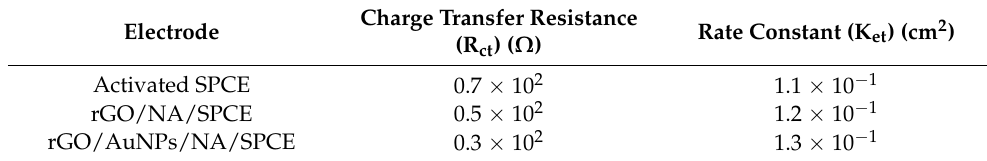
Table 1. The values of charge transfer resistance (R ct ) and rate constant (K et ) for bare and modified